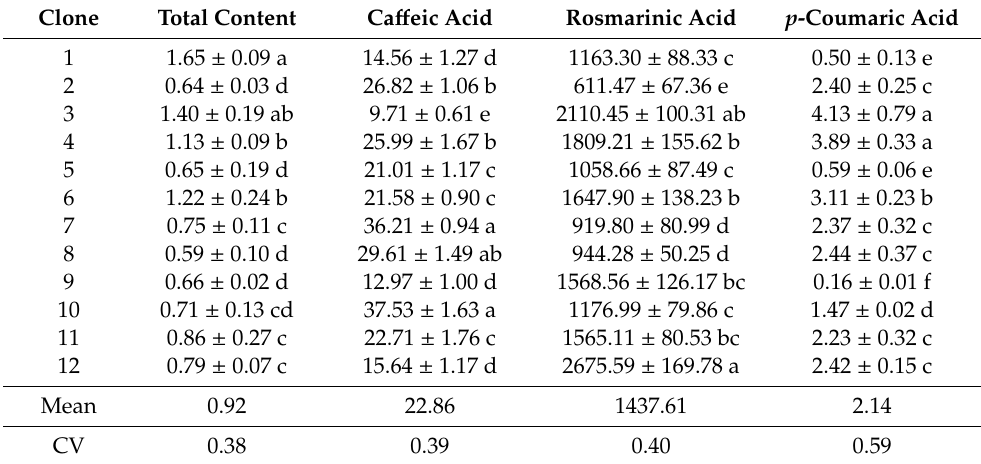
Table 6. The total content (g × 100 g − 1 DW) and chemical composition of phenolic acids (mg × 100 g − 1 DW). Clone Total Content Ca ff eic